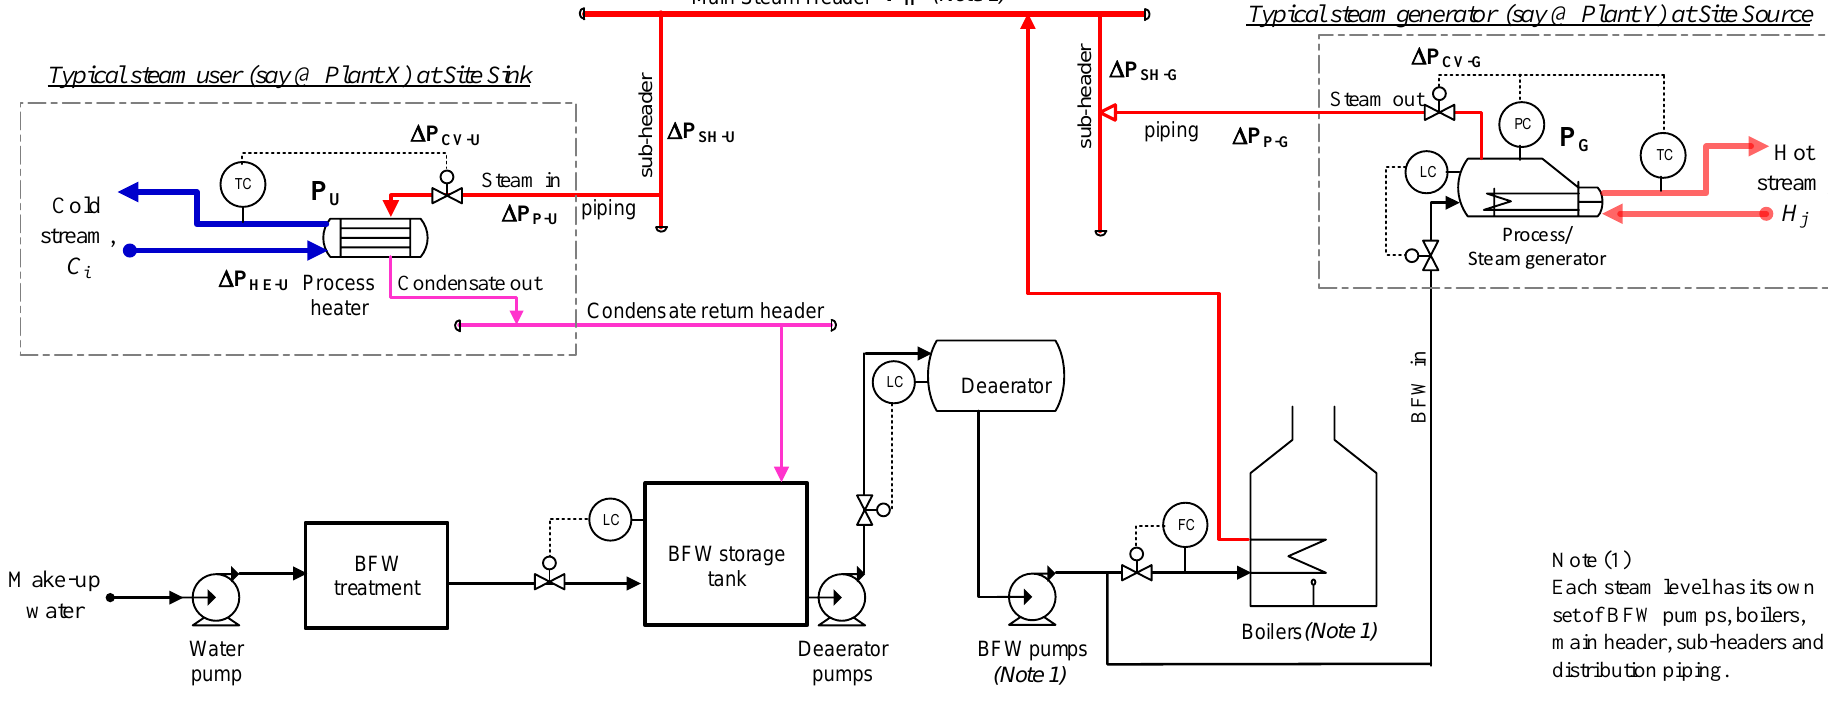
Figure 3. Process flow diagram—a typical steam generation, distribution and utilisation system at a